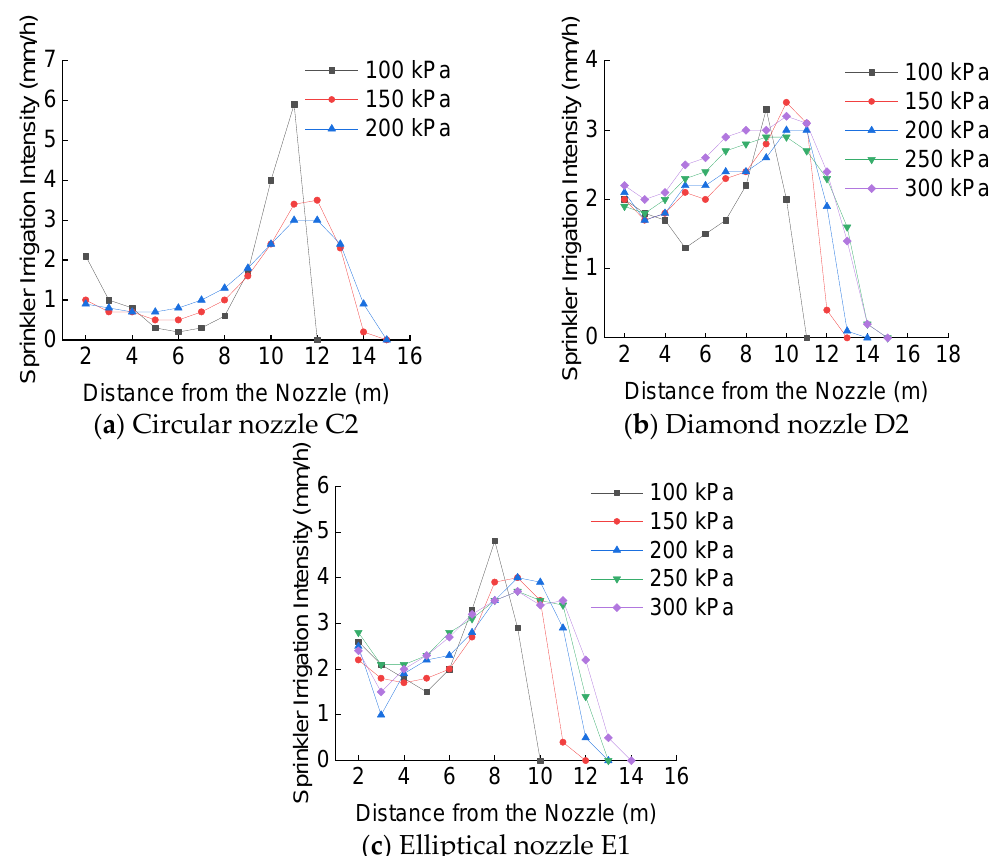
Figure 7. Radial water distribution of different nozzles under different working pressures. (C2 refers to the circular nozzle with a diameter of 5 mm; D2 refers to the diamond nozzle with an aspect ratio of 1.32; E2 refers to the elliptic nozzle with an aspect ratio of 2).